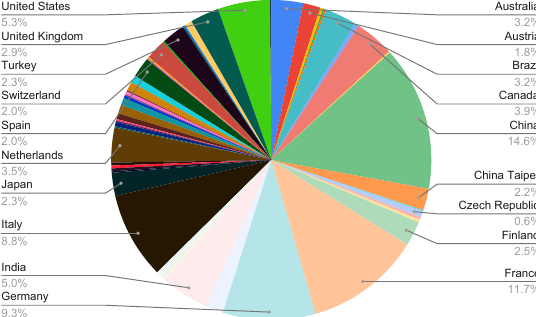
Figure 2. Papers were reviewed by 684 reviewers from 55 countries.